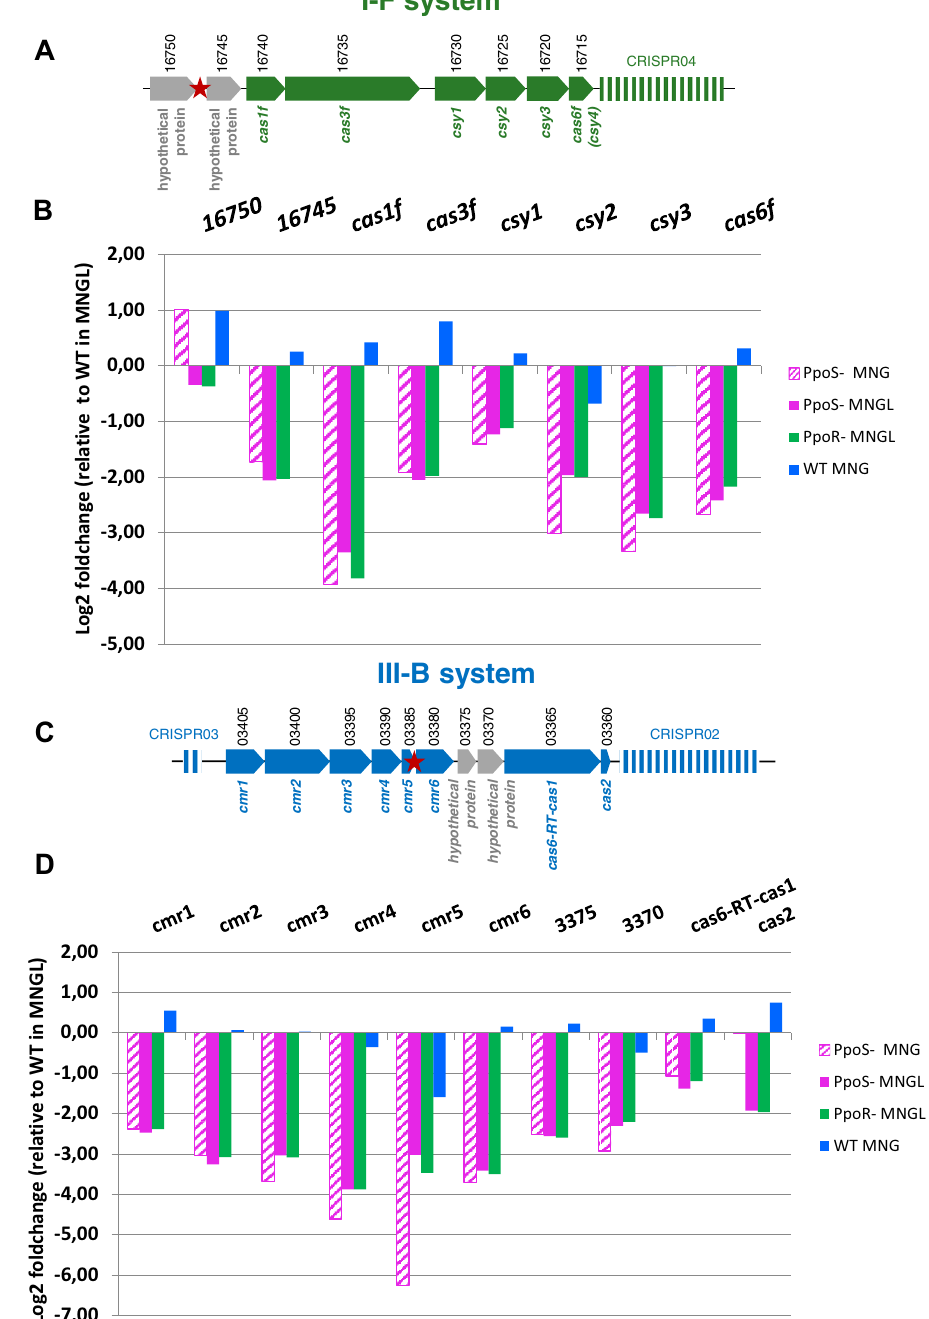
Figure 3. Regulation of CRISPR-Cas expression in M. mediterranea by the histidine kinase PpoS and the response regulator PpoR. ( A ) Schematic representation of the I–F CRISPR-Cas system. The CsrA1 potential binding site is marked with a red star. ( B ) Transcriptomic levels of the I–F CRISPR-Cas system in different genetic backgrounds and MNGL or MNG media relative to the WT levels in MNGL. ( C ) Schematic representation of the III-B CRISPR-Cas system. The CsrA1 potential binding site is marked with a red start. ( D ) Transcriptomic levels of the III-B CRISPR-Cas system in different genetic backgrounds and MNGL or MNG media relative to the WT levels in MNGL. The genes in grey are not present in all similar CRISPR-Cas